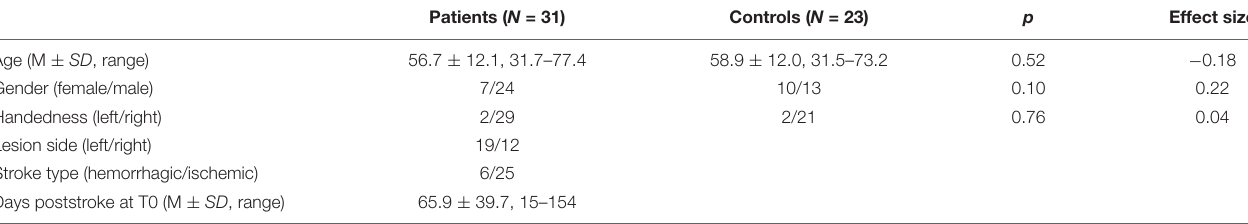
TABLE 1 | Sample demographics and clinical information.